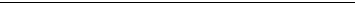
on. In this way the effect of prolonged exposure to malaria during childhood is